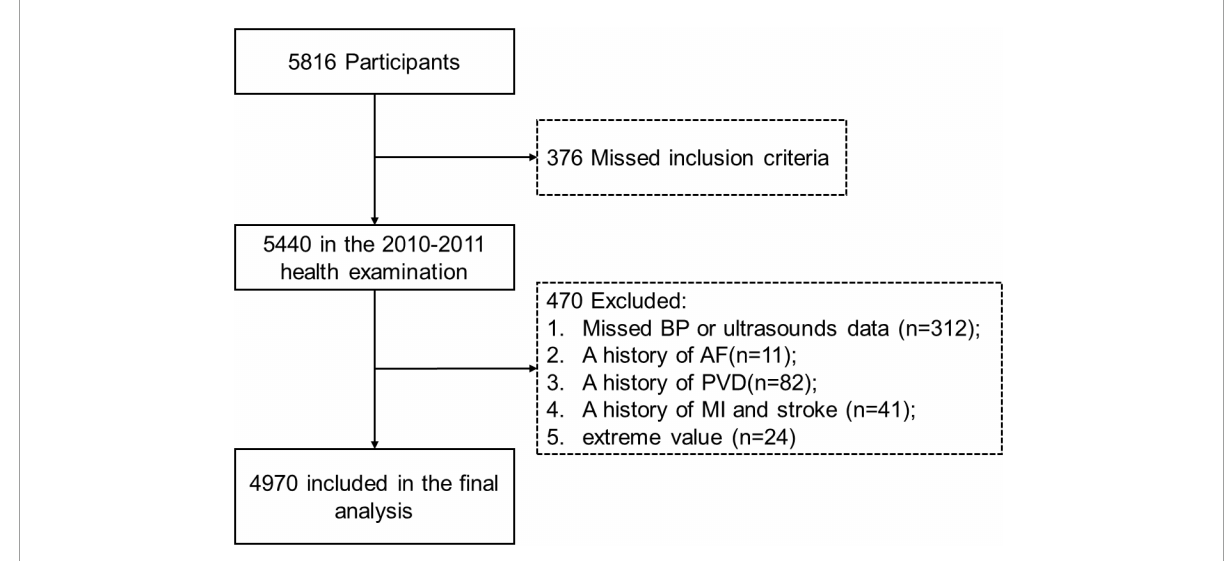
FIGURE1 Selection of study population. BP, blood pressure; AF, atrial fibrillation; PVD, peripheral vascular disease; MI, myocardial